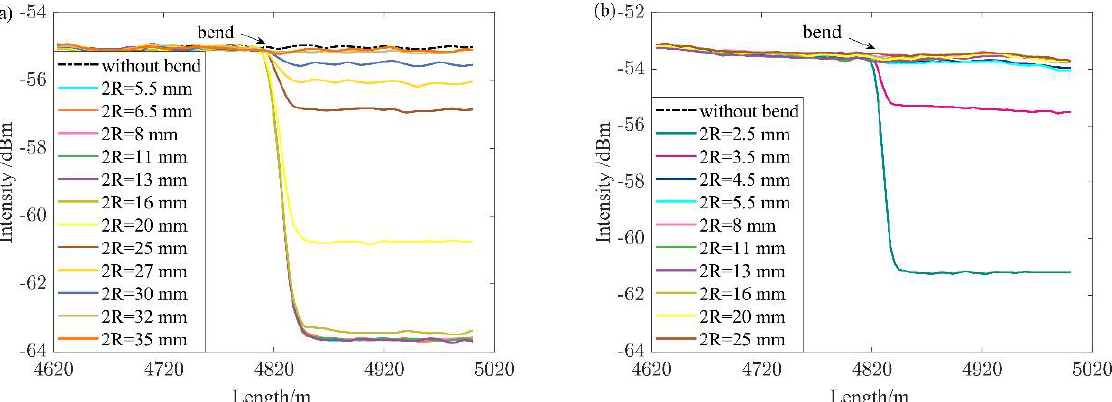
Figure 8. Measured Brillouin signals intensity with different bending radii. ( a ) SMF; ( b ) SMF alignment fusion to 50 μm GI-MMF.